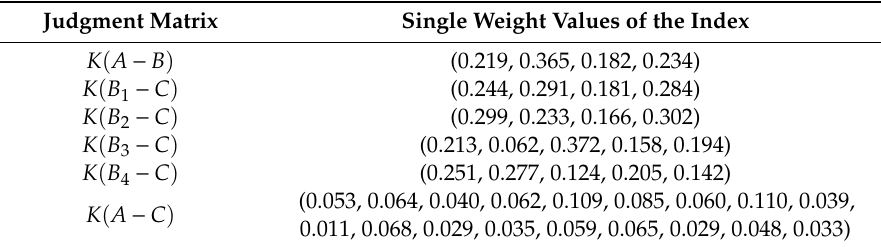
Table 6. Single weight values of indexes at all